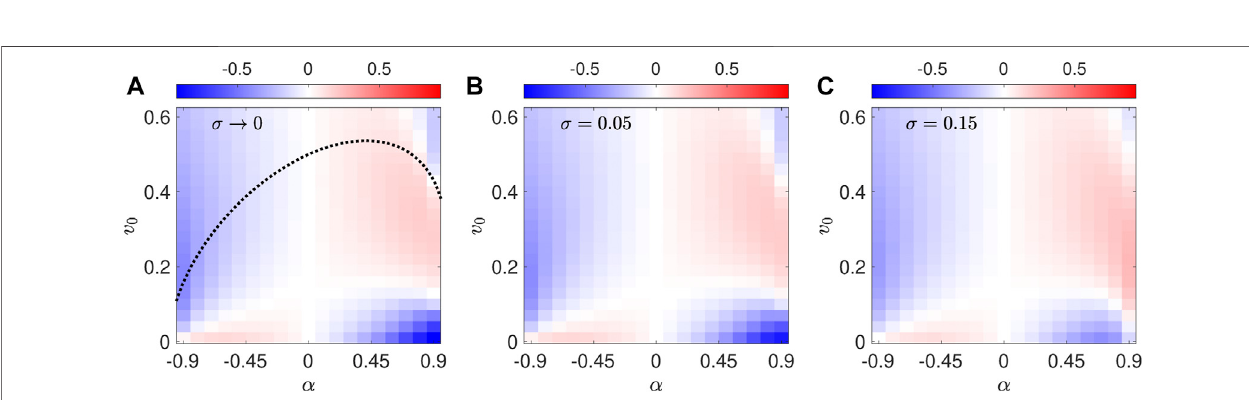
FIGURE12| Depletionindex I D asafunctionof( v 0 , α )for fi xed valuesof σ . (A) σ → 0,usingtheaverageddrift-diffusionmodeland Eq.40 .Theblack dottedcurveis the bifurcation curve from Figure 3 . (B) σ (cid:1) 0.05, from the Fokker-Planck model. (C) σ (cid:1) 0.15, from the Fokker-Planck model.